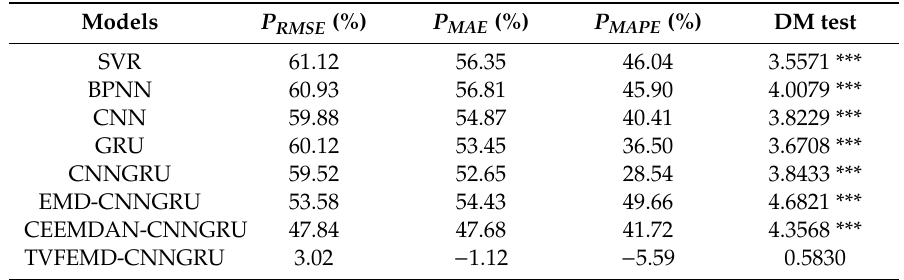
Table 6. Indicator decline ratios and the Diebold–Mariano (DM) test results illustrating the performance improvement of the proposed model.